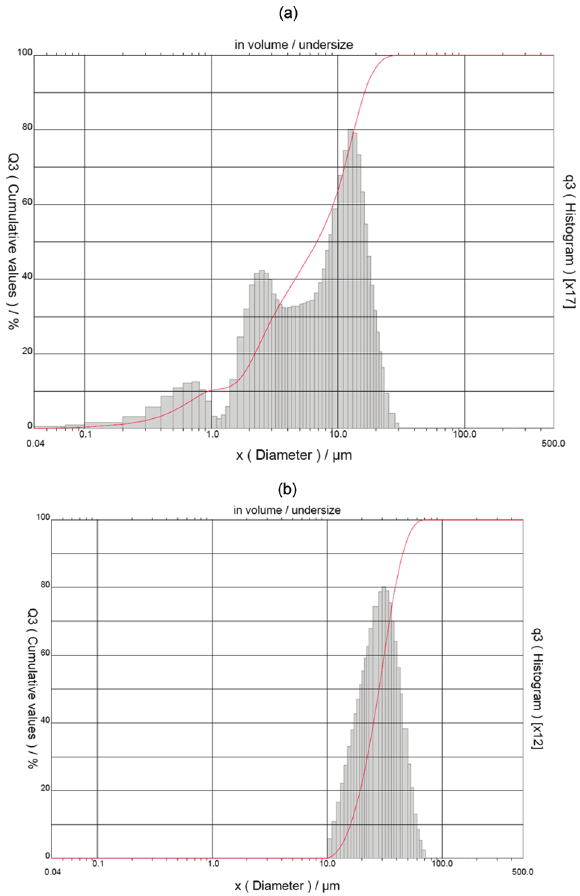
Figure 2 : Particle size distribution of (a) CrB 2 and (b) Nb